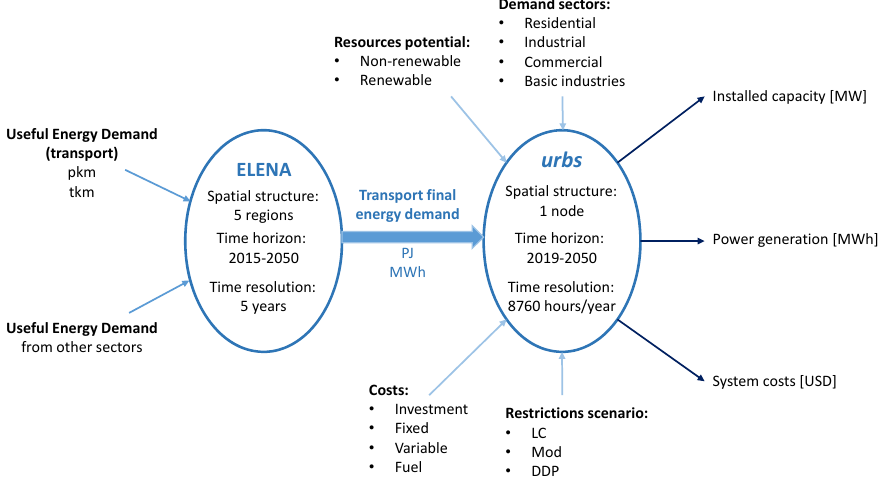
Figure 2. ELENA and urbs relationship in the context of this